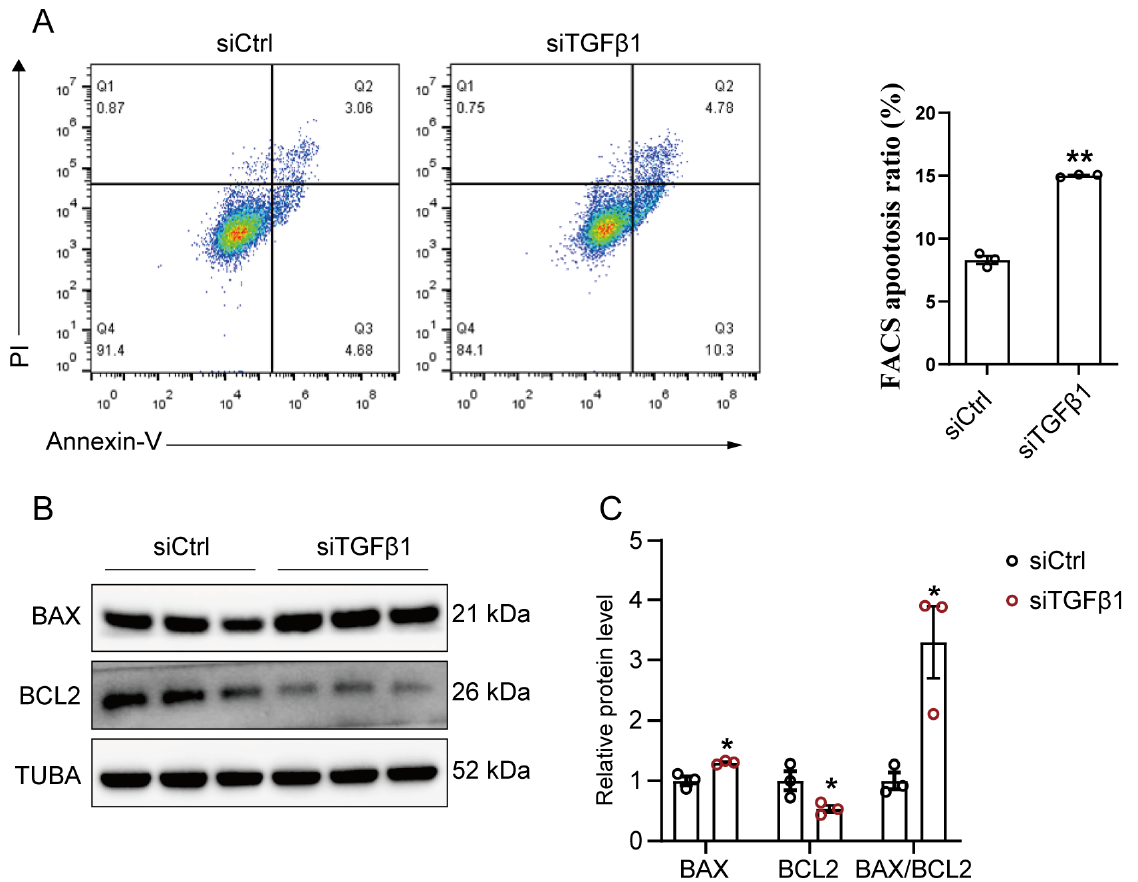
Figure 3. Silencing TGF β 1 promotes apoptosis of myoblast: ( A ) After transfection with control siRNA (siCtrl) or TGF β 1 siRNA (siTGF β 1) for 36 h, cell apoptosis was detected using flow cytometry; ( B ) The protein level of BAX and BCL2 in siCtrl and siTGF β 1 cells, as detected by Western blot; ( C ) Quantification of Western blots in ( B ). The data were obtained from at least three independent experiments. Results are expressed as mean ±SEM; * p < 0.05, ** p < 0.01.